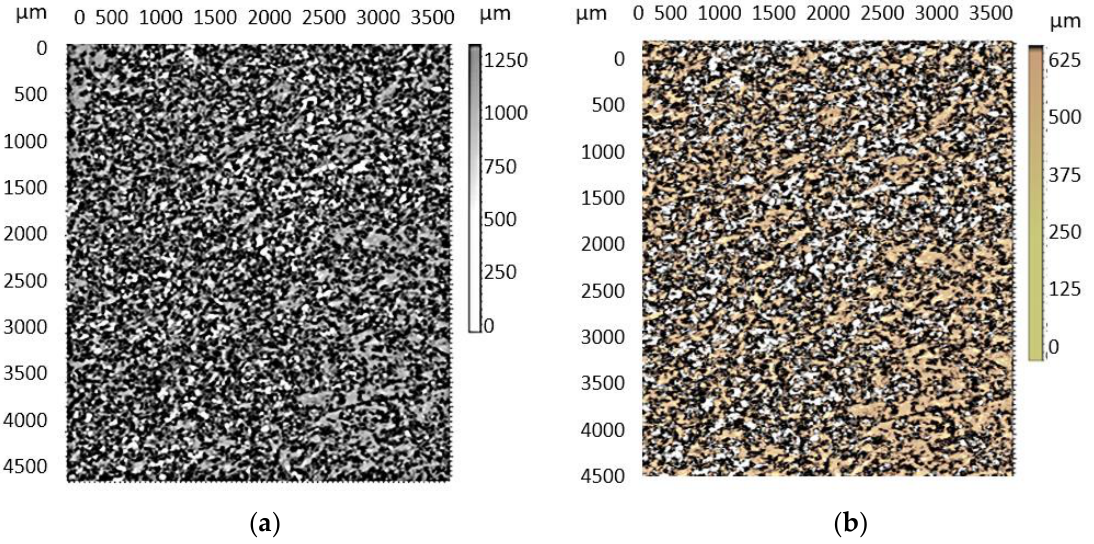
Figure 9. Topography of the surface layer of the part’s breaking surface. ( a ) — new parts; ( b ) — parts subject to the process of artificial aging.